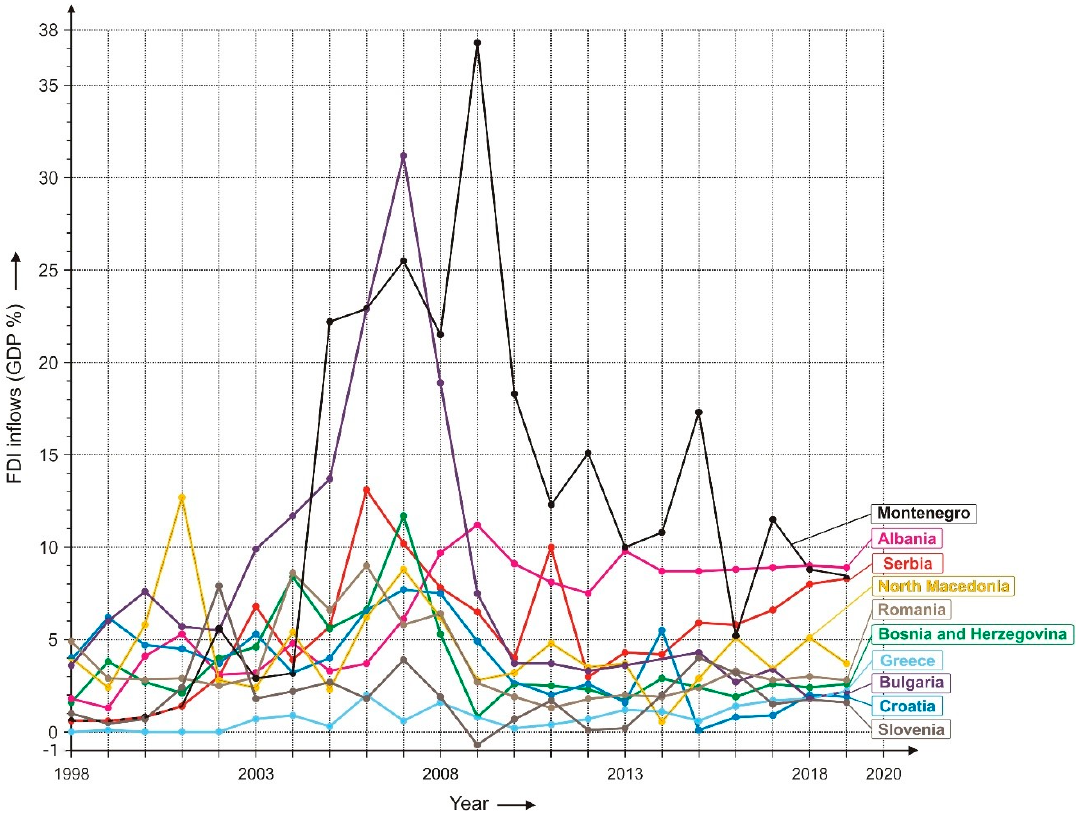
Figure 2. FDI inflows in ten Balkan countries (1998–2019) (Authors’ creation).